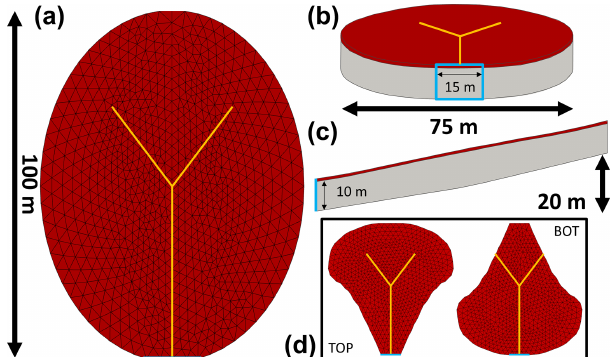
Figure 1. 3-D model domain and shape of the virtual catchment from the top (a) , front (b) and side (c) . The blue square indicates the outflow boundary with constant head condition. The red layer represents the soil, which has a much higher hydraulic conductiv- ity than the underlying bedrock (grey). The orange lines indicate the zone of convergence (but no explicit channel). The two addi- tional catchment shapes (top-heavy and bottom-heavy) we tested in Sect. 2.2.1 are shown in the black box (d)